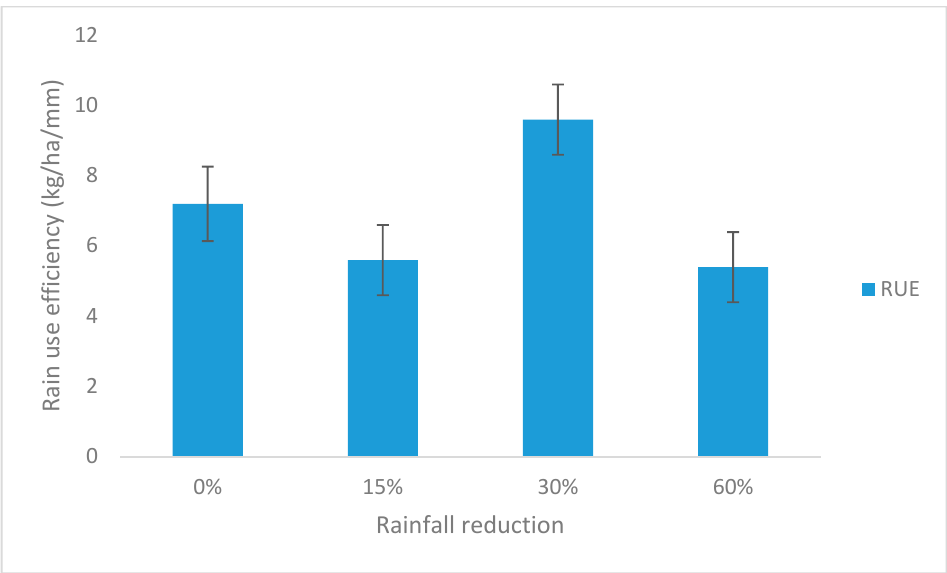
Figure 7. Rain use efficiency (RUE) of the semiarid grassland as affected by different intensity of rainfall reduction (RR) in Pretoria. Table 4. Percentage species contribution on grass ANPP of the semiarid grassland as affected by different intensity of rainfall reduction (RR) in Pretoria.